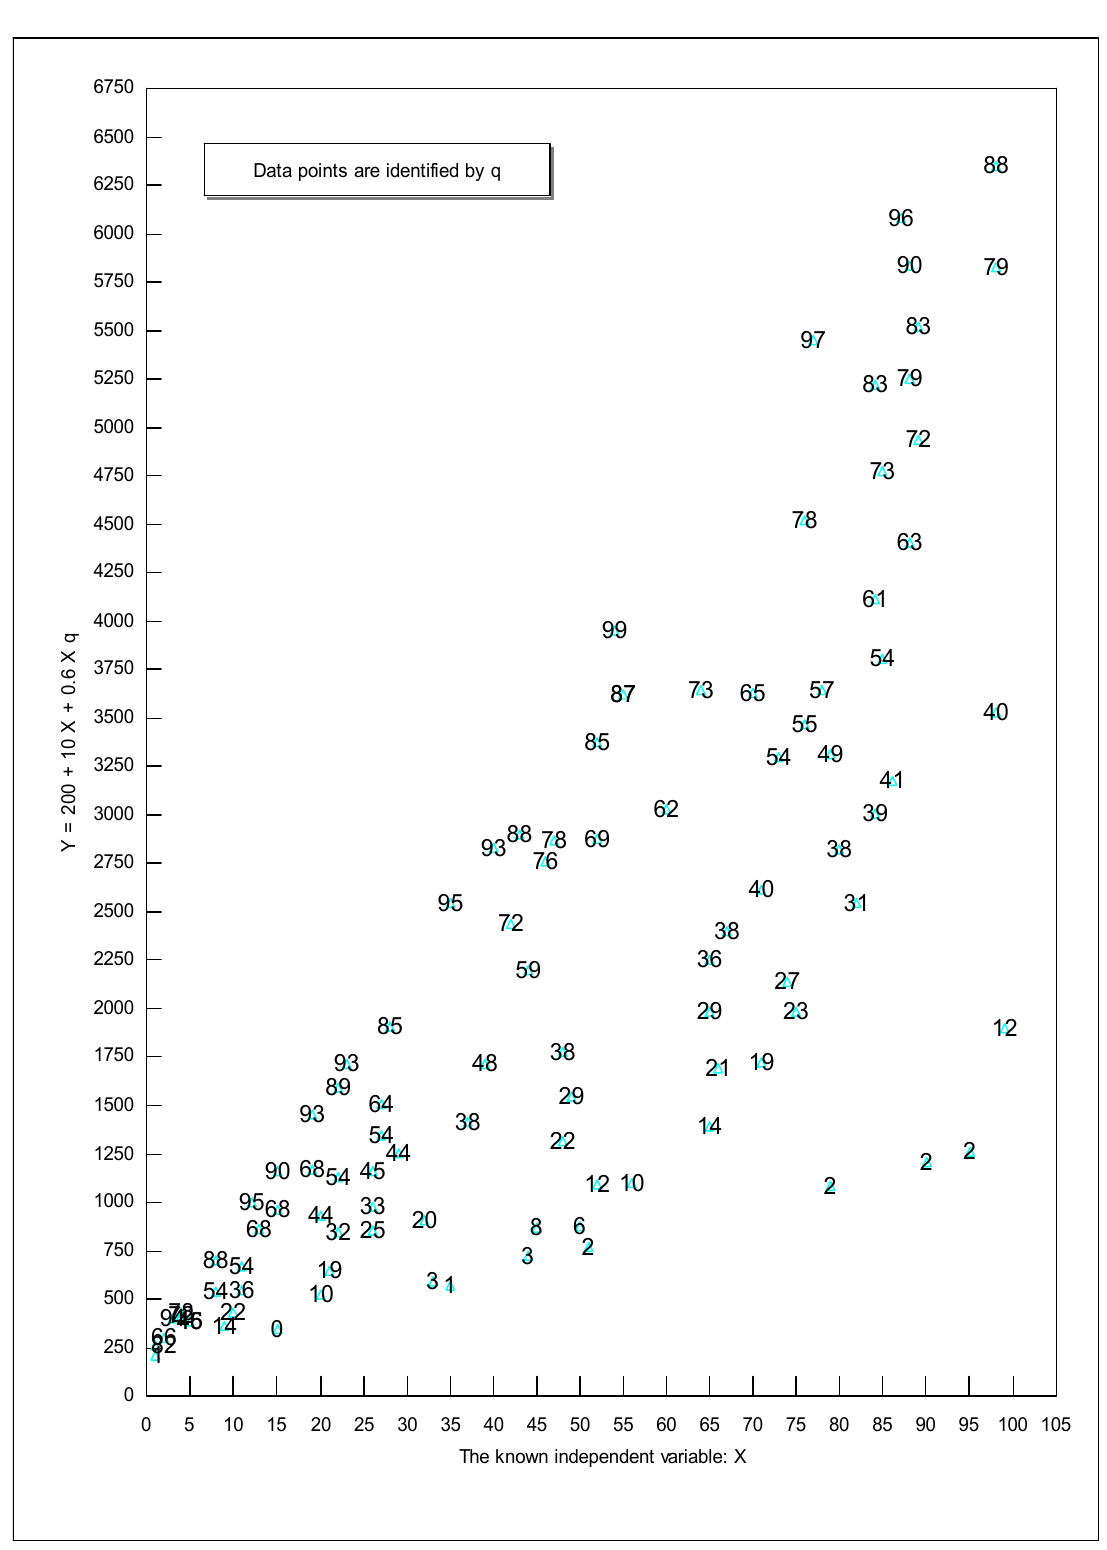
Figure 1. The intuition underlying variable slope estimators.